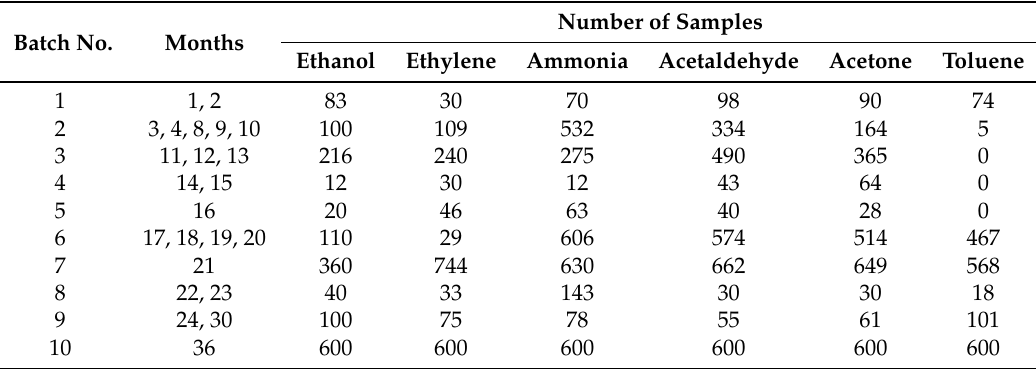
Table 1. Dataset of sensor drift in E-Nose systems